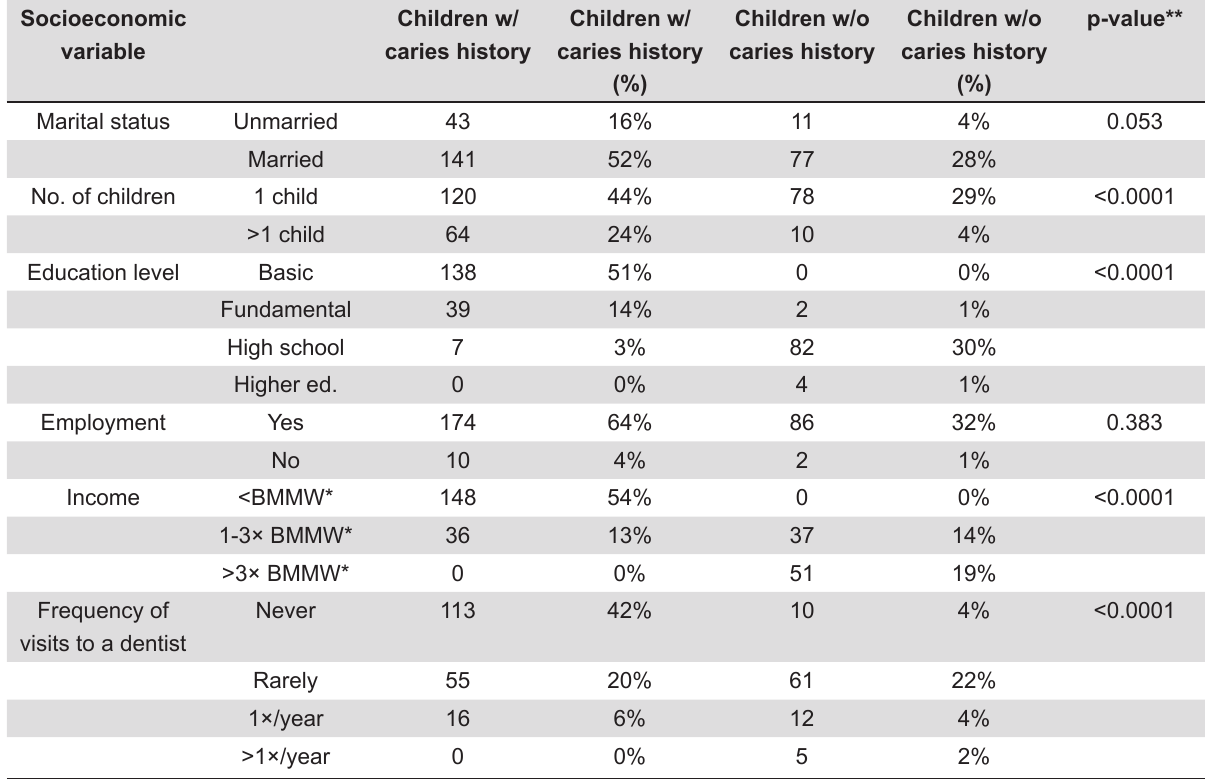
Table 2- Association between maternal socioeconomic variables and caries history of children enrolled in public institutions of early childhood education in southern